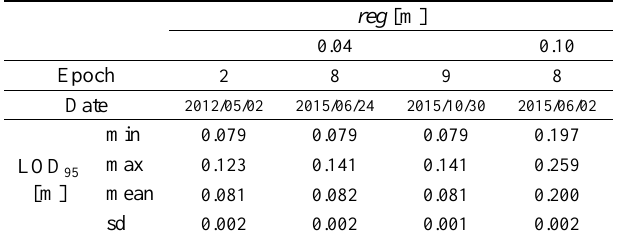
Table 1. Descriptive statistics per point cloud epoch for the LOD 95 calculated with two different registration errors ( reg ).